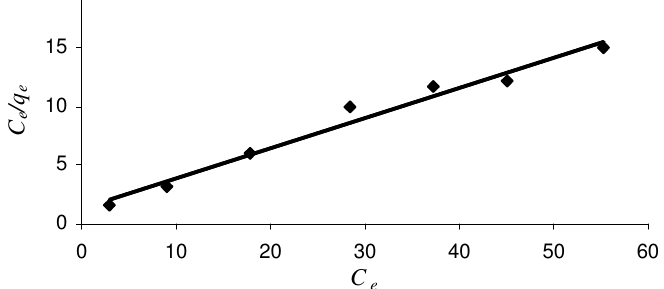
Figure 7. Langmuir isotherm model for present system (V=200 mL, Adsorbent dosage=0.8 g, pH=7, T=20 0 C, Contact time=3 days) Table 1. Parameters of Freundlich and Langmuir Isotherm